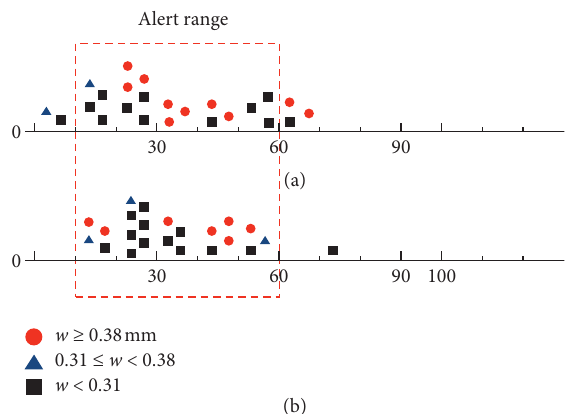
Figure 19: Distribution of cracking segments: (a) westbound tunnel and (b) eastbound tunnel.